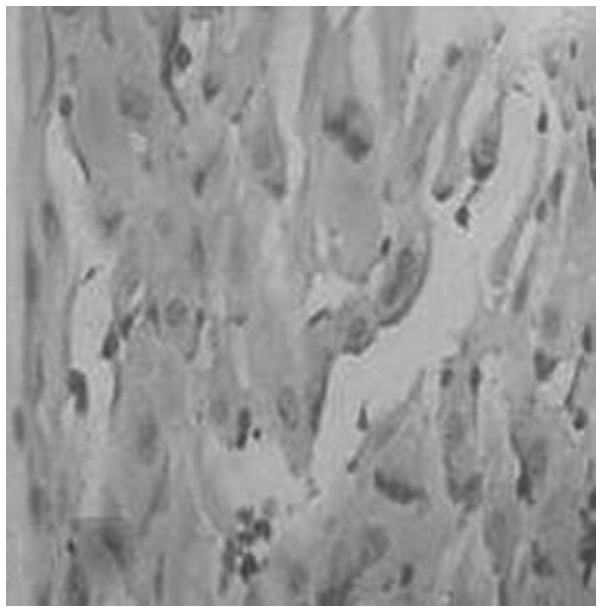
Immunohistochemical staining for matrix metelloproteinase-1 in a normal decidua. Magnification, ×400.